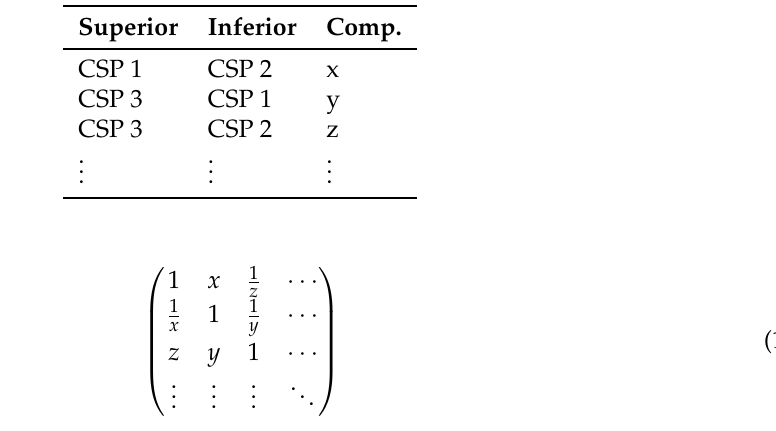
Table 10. Comparison